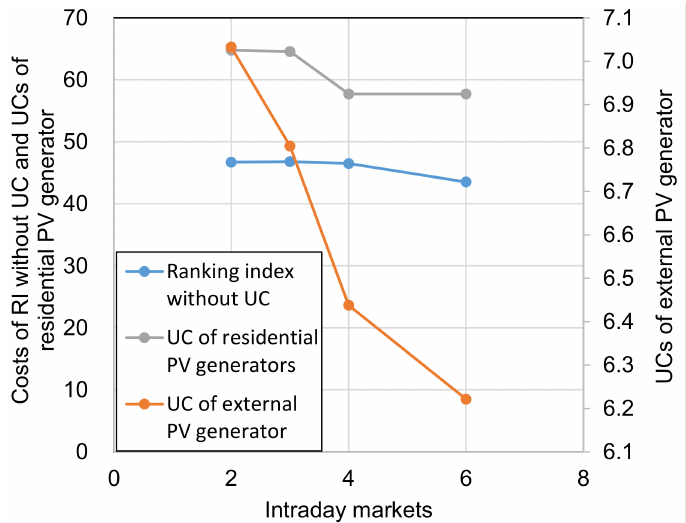
Figure 6. UCs of PV generators varying